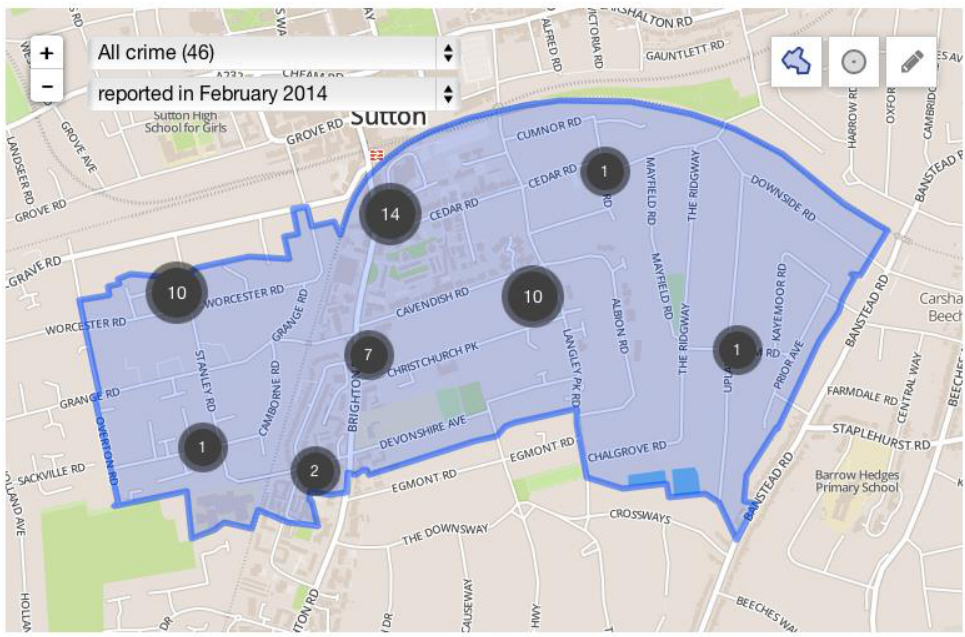
F igure 4: Screen shot of the police.uk ‘street - level’ crime map clearly explaining the number of crimes that the force were unable to map to a specific location for this particular